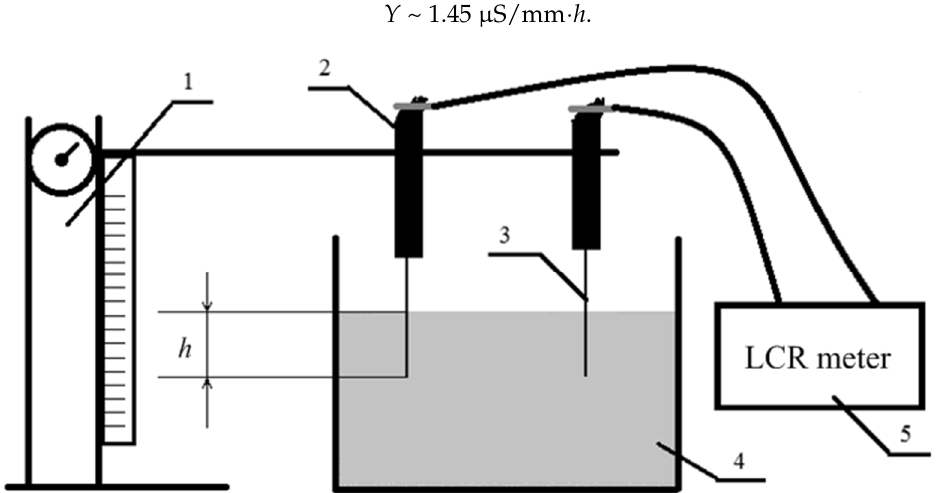
Figure 6. Calibration scheme of the installation for determining the critical length of carbon fibers: 1 is the cathetometer, 2 is the plastic specimen, 3 is the single carbon filament, 4 is the electrolyte solution, and 5 is the LCR meter.